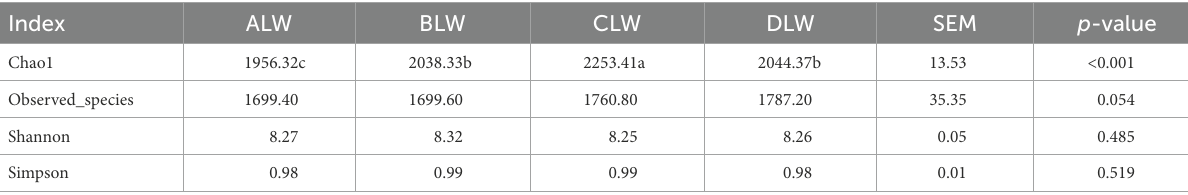
TABLE 4 The effect of EOZB on ileum alpha diversity